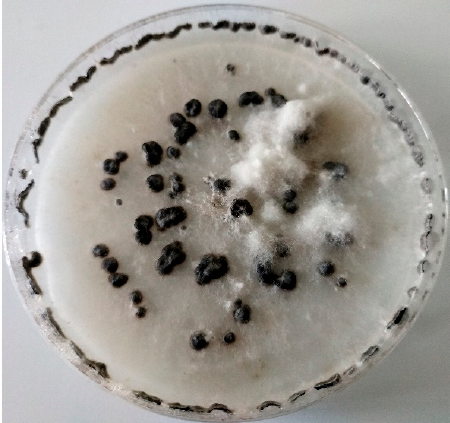
Figure 3. Botrytis cinerea isolated on PDA medium from ecological strawberry plantation after 10 days of incubation in 22 °C.